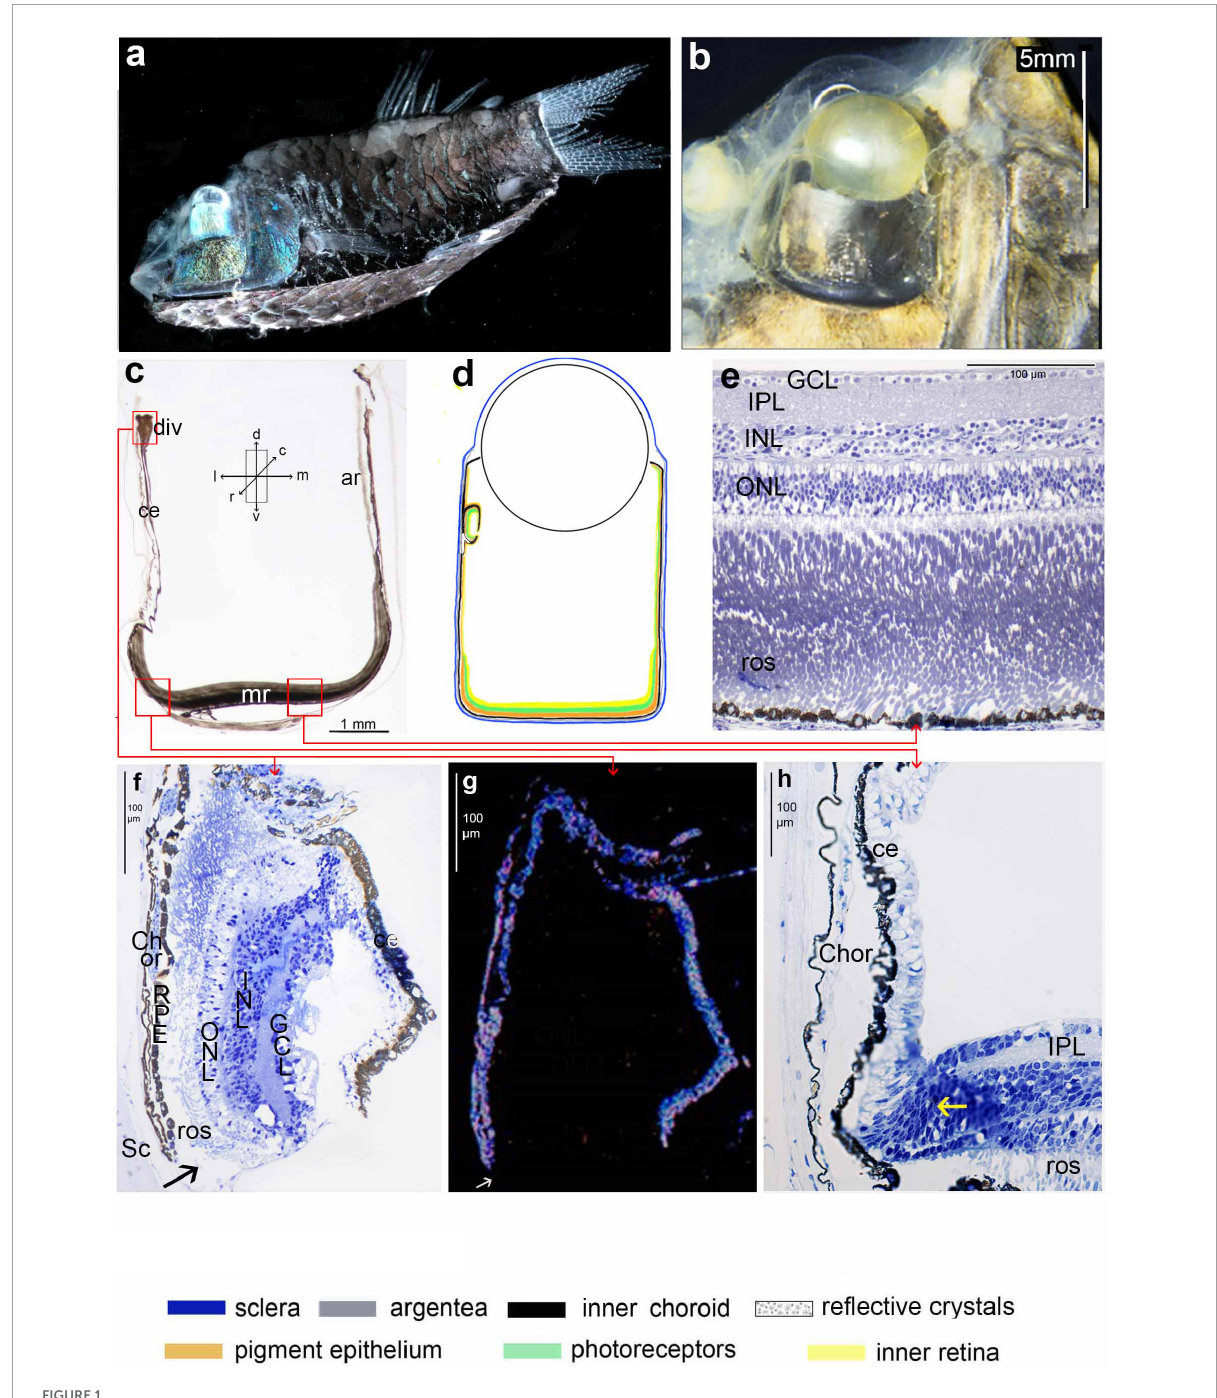
FIGURE1 Opisthoproctus soleatus : (a) side view of an entire animal (SL 42 mm) showing the tubular eye and the flattened sole plate on the ventral surface of the animal (courtesy E. Widder); (b) head of another individual used for histology in this study (SL 42 mm); (c) approximately transverse thick section of tube eye with lens removed: note the well-developed main retina on the base of the tube, the accessory retina on the medial wall and the ciliary epithelium on lateral wall with a diverticulum dorsally; (d) schematic diagram of ocular layers; the colour code listed at the bottom of the figure applies to this and subsequent diagrams; (e) radial semithin section of the main retina; (f) radial semithin section of diverticulum. The ventral arrow indicates the point of entry of light through an unpigmented region of the lateral wall of the diverticulum; (g) same section as f seen in dark-field illumination highlighting reflective structures in the choroid and pigment epithelium; (h) radial semithin section of the transition of the main retina to the lateral wall, the yellow arrow indicates the cell proliferation zone. The approximate orientation relative to the body axis of panels (c–h) is indicated by the arrows shown in the inset of panel (c) but see Materials and Methods for comments on deviations from the transverse plane in histological